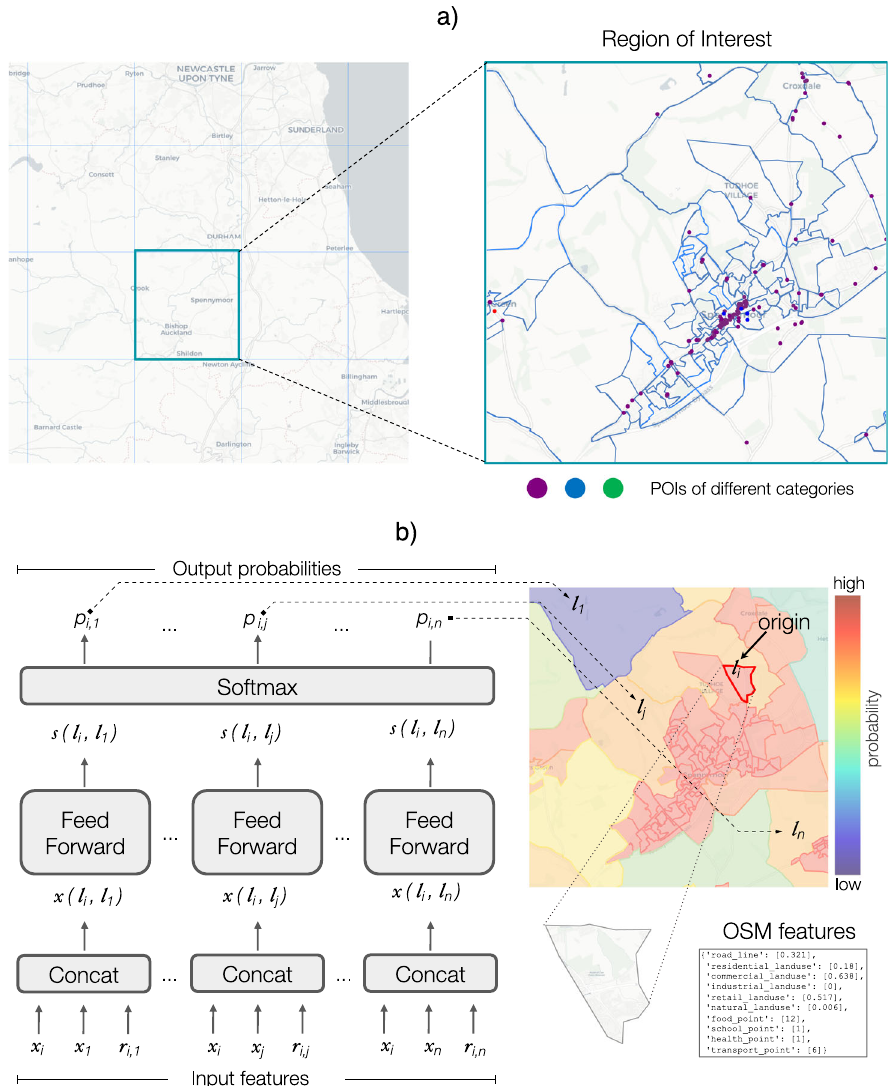
Fig. 1 Flow generation and architecture of Deep Gravity. a The geographic space is divided into regions of interest (squared tiles). Each region of interest is further split into locations using Output Areas (OAs, for England), Census Areas (CAs, for Italy), or Census Tracts (CTs, for New York State). Each location may have several Points Of Interest (POIs, the colored points), extracted from OpenStreetMap (OSM). During the training phase, half of the regions of interest are used for training the model and the remaining half to test the model ’ s performance. b Architecture of Deep Gravity. The input features x i (feature vector of the origin location l i ), x j (feature vector of the destination location l j ), and r i , j (distance between origin and destination) are concatenated to obtain the input vectors x ( l i , l j ). These vectors are fed, in parallel, to the same feed-forward neural network with 15 hidden layers with LeakyReLu activation functions. The output of the last hidden layer is a score s ( l i , l j ) ∈ [ − ∞ , + ∞ ]. The higher this score for a pair of locations ( l i , l j ), the higher the probability to observe a trip from l i to l j . Finally, a softmax function is used to transform the scores into probabilities p i , j , which are positive numbers that sum up to